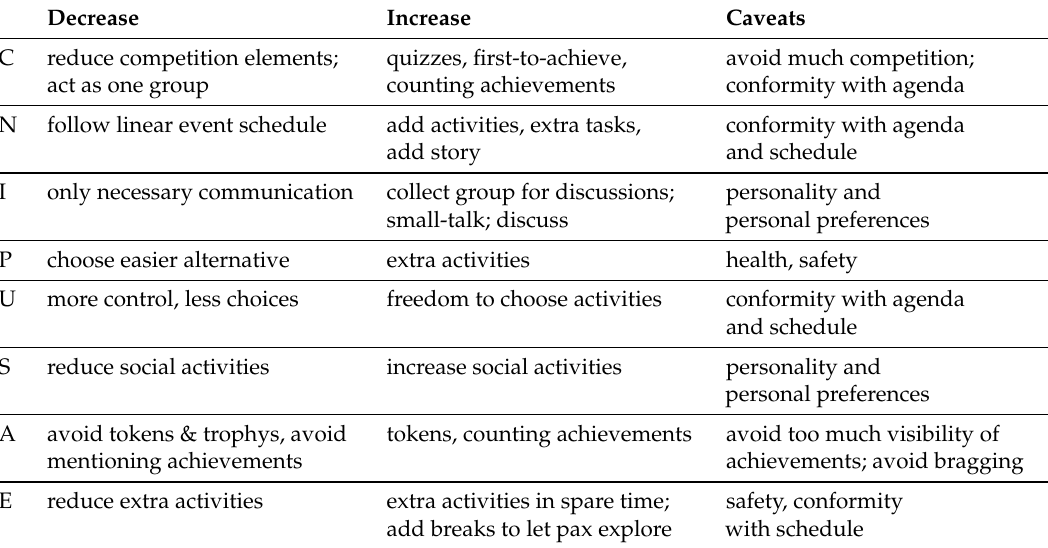
Table 4. Means to decrease and increase engagement during guided trekking